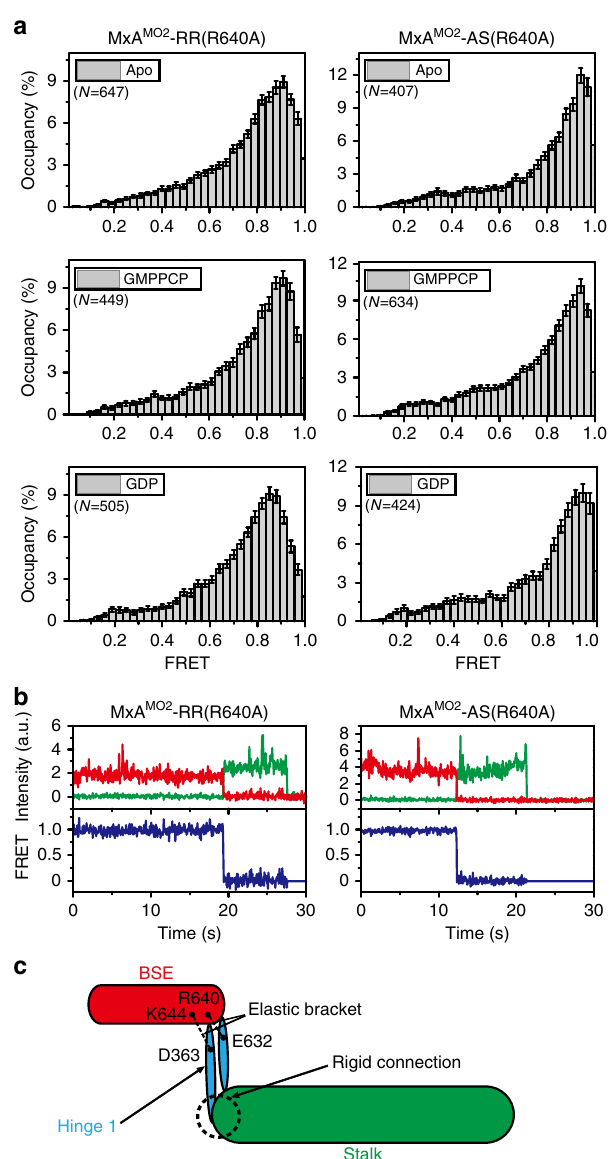
Figure 5 | R640A abolishes the flexibility of MxA. ( a ) Histograms of FRET data of MxA MO2 -RR(R640A) (left) and MxA MO2 -AS(R640A) (right) in different nucleotide-loading conditions. Error bars indicate s.d. of 1,000 bootstrap samples of the FRET traces. ( b ) Representative traces coloured as in Fig. 2c for MxA MO2 -RR(R640A) (left) and MxA MO2 -AS(R640A) (right) in apo condition. ( c ) Schematic drawing of the dual-salt-bridge bracket between the BSE and hinge 1.